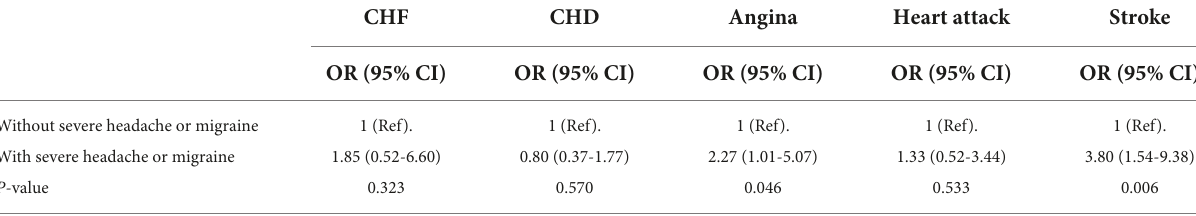
TABLE 3 Adjusted odds ratios (95% CI) for association between severe headache or migraine and individual CVDs. CHF CHD